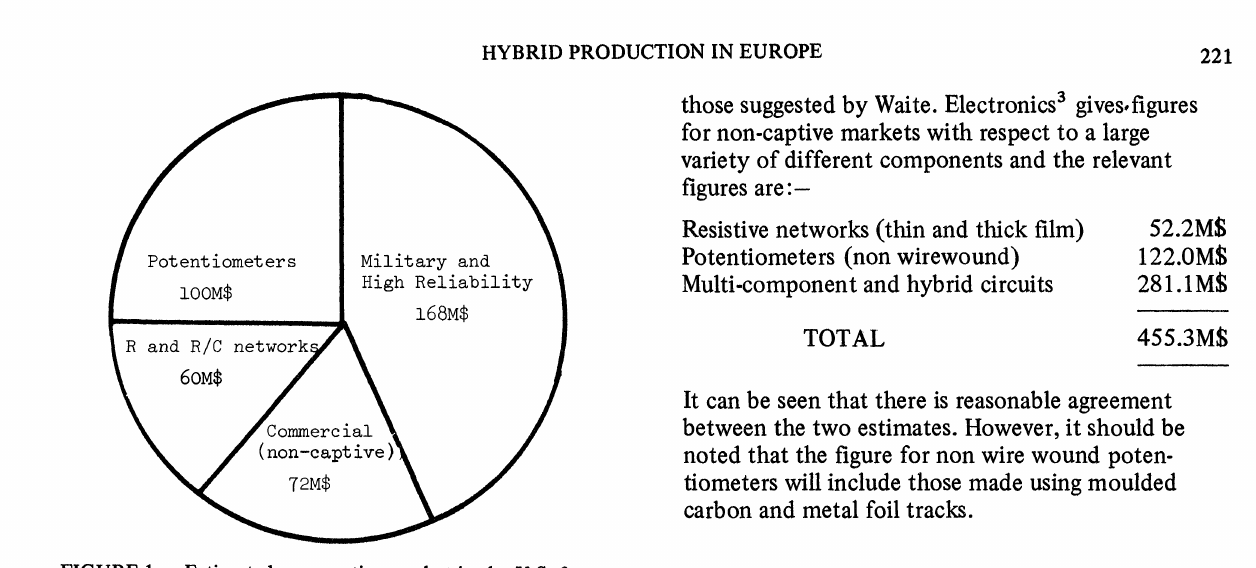
Estimated non-captive market in the U.S. for hybrid circuits production in 1977 (after Waite, Ref.